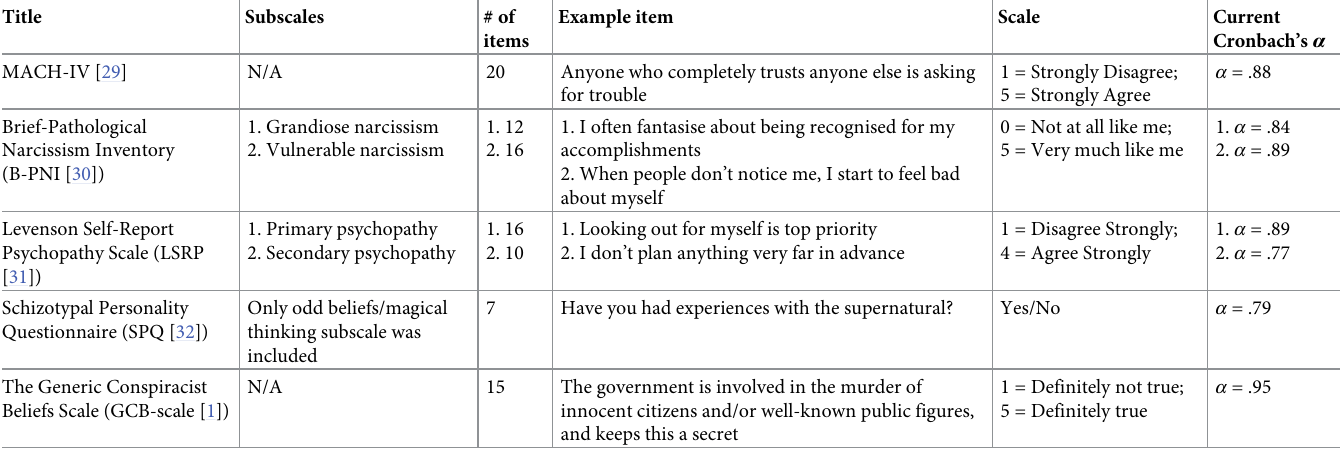
Table 1. Overview of measures included in the study questionnaire.